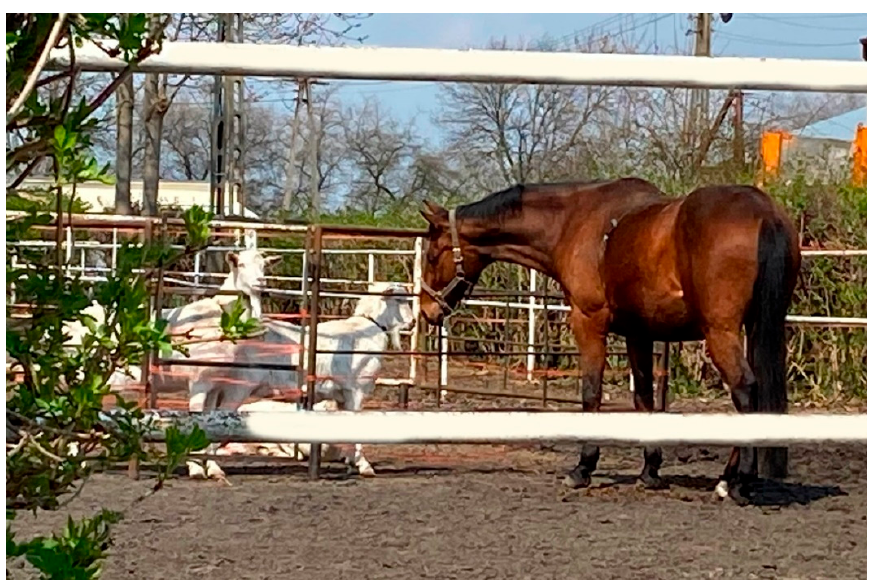
Figure 2. Interactions between a horse and a goat during the experiment.